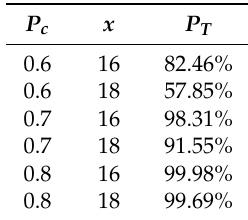
Table 4. Identification results for various P c under f “